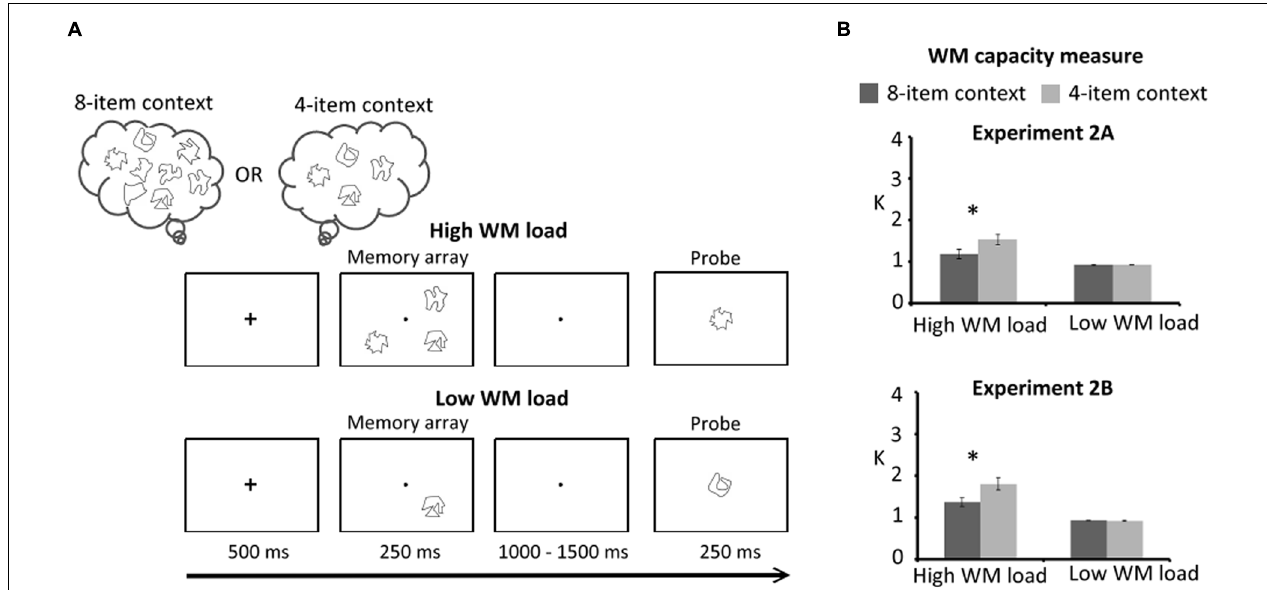
FIGURE 2 | (A) Schematic illustration of the delayed response task of Experiments 2A and 2B. Participants were instructed to remember three shapes (high WM load) or one shape (low WM load) within the memory array for a delayed response. The order of task contexts was counterbalanced across participants in Experiment 2A (half of the participants performed the 8-item context first) and Experiment 2B (controlled in a Latin Square design). (B) WM capacity ( K estimates) for Experiment 2A (upper panel) and Experiment 2B (lower panel). Error bars represent standard errors of the means. WM, working memory.